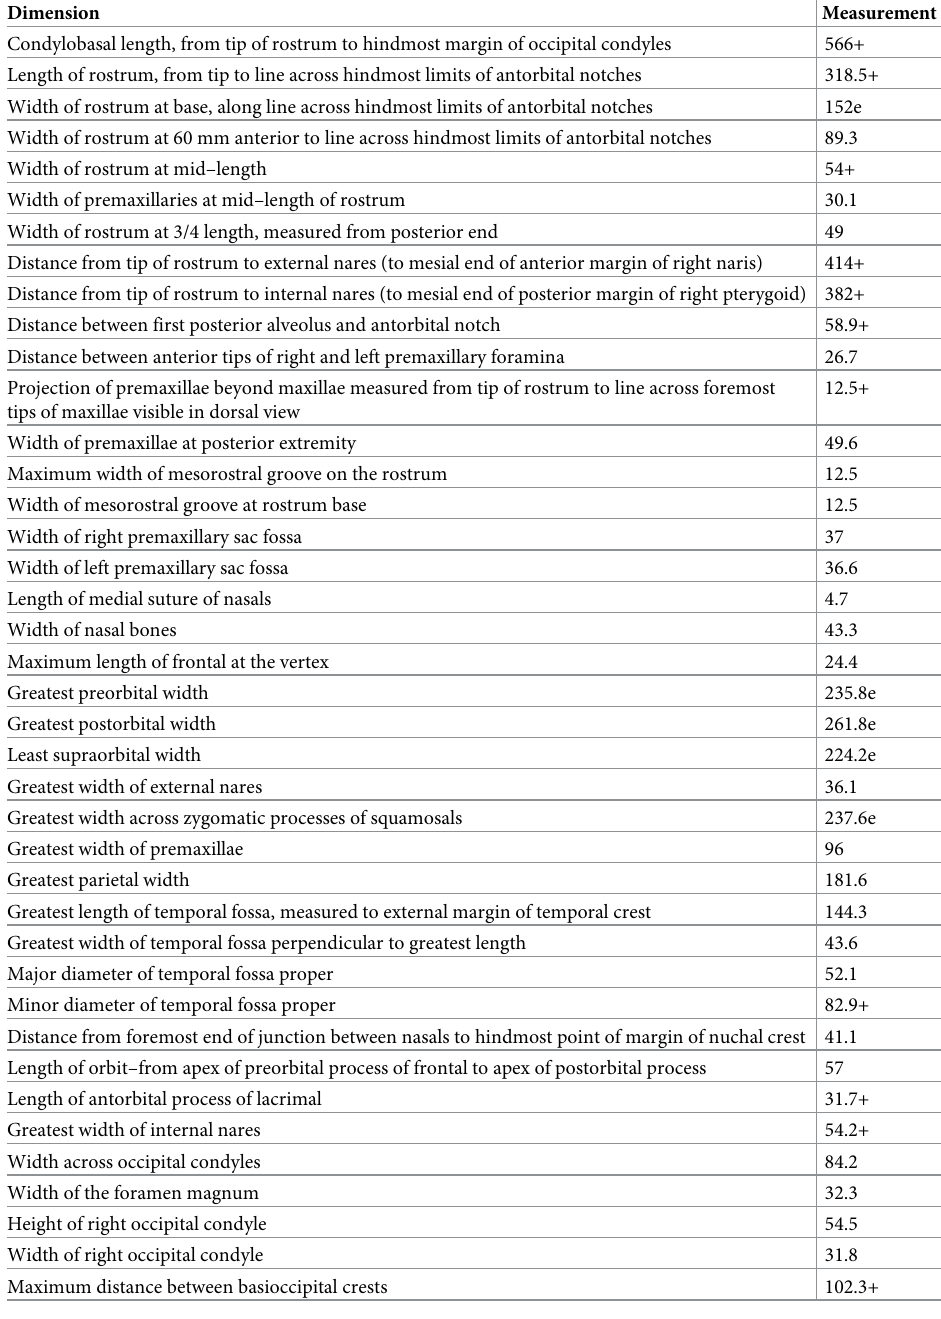
are symmetrical in the dorsal view, while the vertex is slightly skewed right to the midline of the foramen magnum because of this deformation. The temporal fossa is dorsoventrally nar- row in lateral view. The dorsal wall of the temporal fossa is low and flat, it is almost horizontal at the level of the orbital fossa, only shows slight posterior elevation.